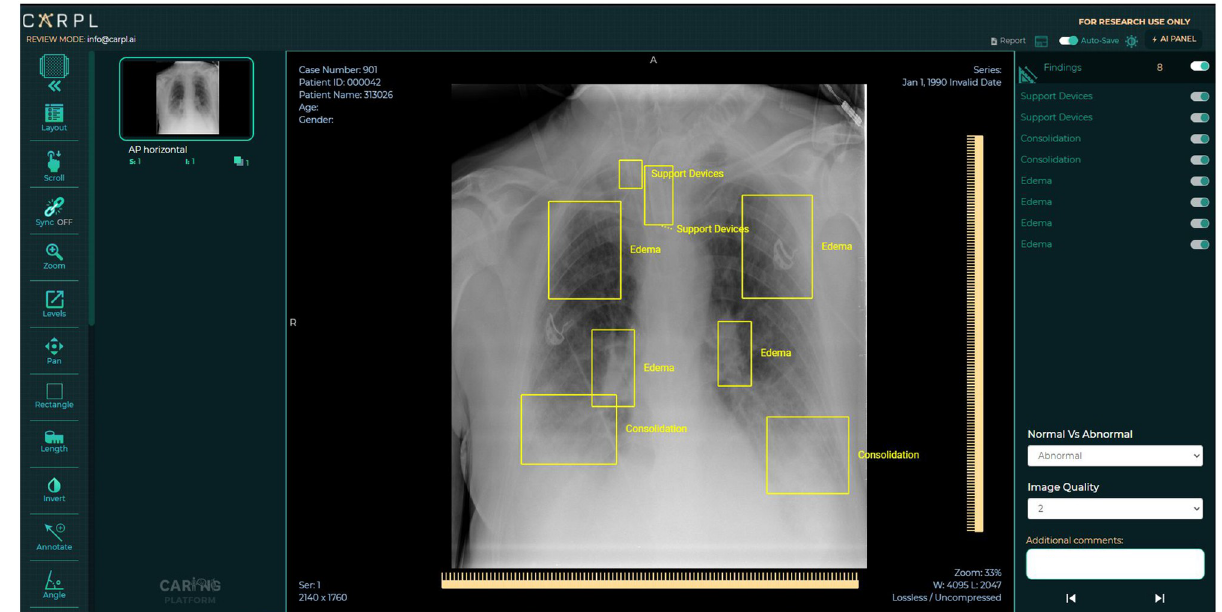
Fig 2. Representative image of the CARPL Annotation Platform tool used for loading DICOM files and subsequently for drawing bounding boxes around each image.